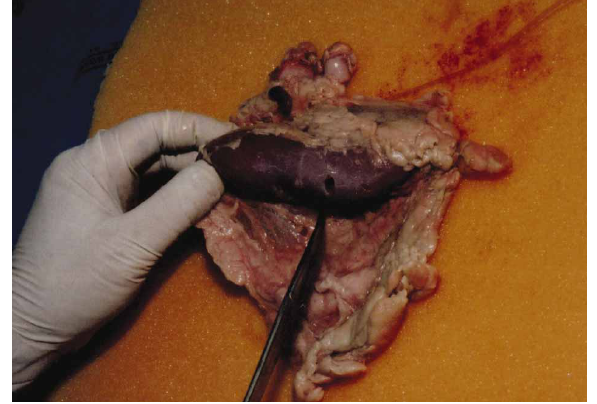
Figure 5 - Amplatz sheath and nephroscope already positioned in the model that is over the radioscopy table.